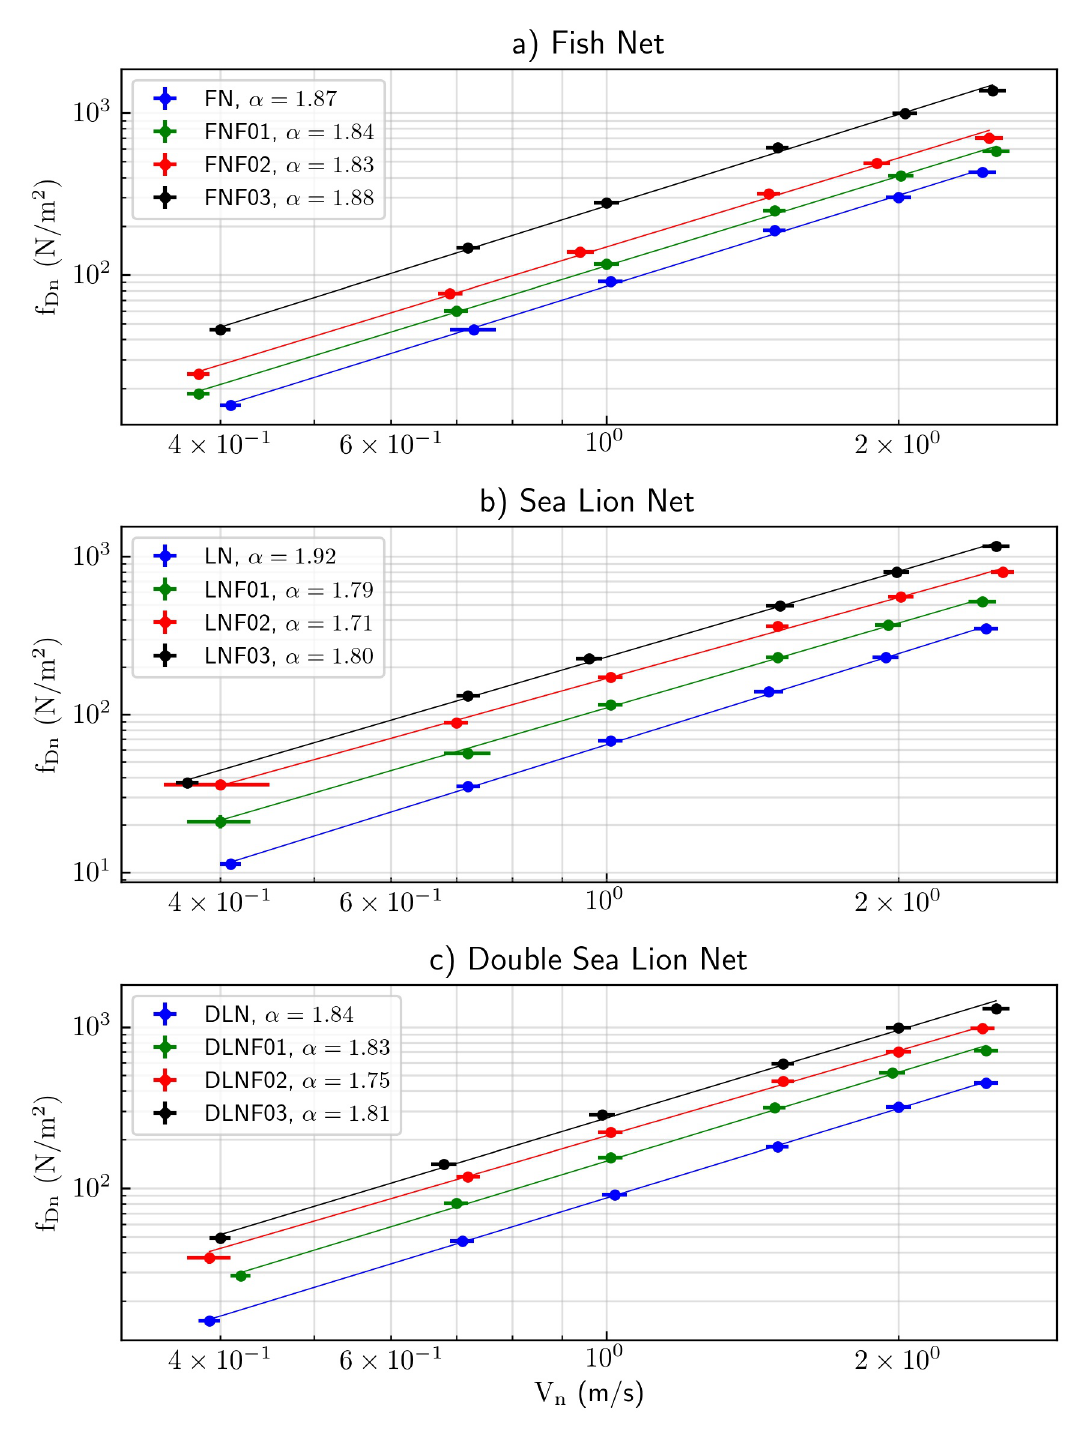
Figure 5. Experimental results of normal drag force for fish and sea lion nets as a function of the speed. Experimental series, clean or without fouling, from Table 1. Lines represent a power law fit of the